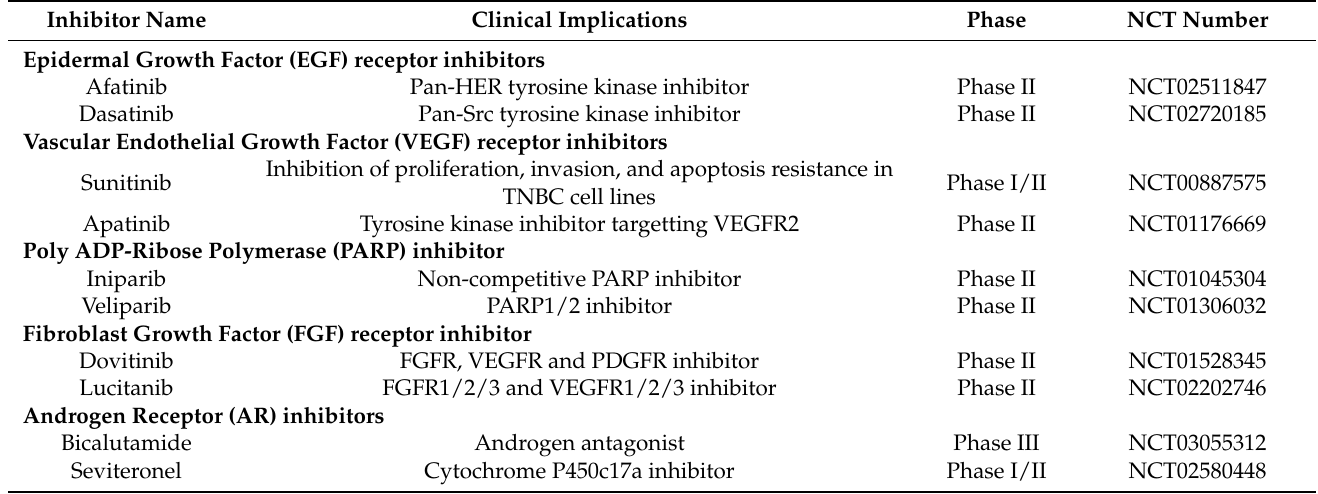
Table 1. Information of representative inhibitors currently undergoing clinical trials for